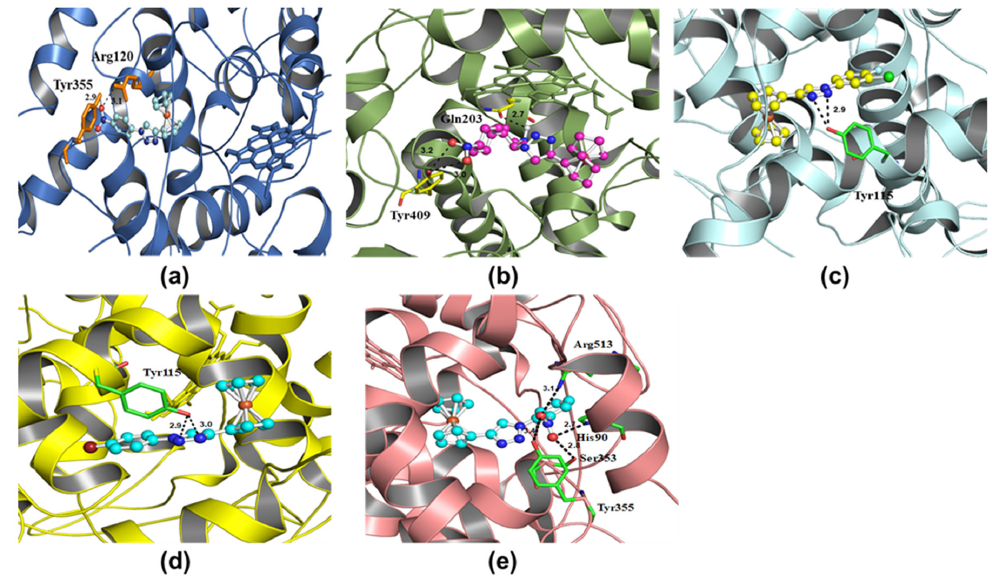
Figure 7. Molecular docking of hybrid compounds X1 ( a ), X2 ( b ), X3 ( c ), X4 ( d ), and X5 ( e ) with cyclooxygenase-2 (PDB code: 6COX). Table 4. Binding energy and interacting residues of X1 – X5 for COX-2 and cPLA 2 .